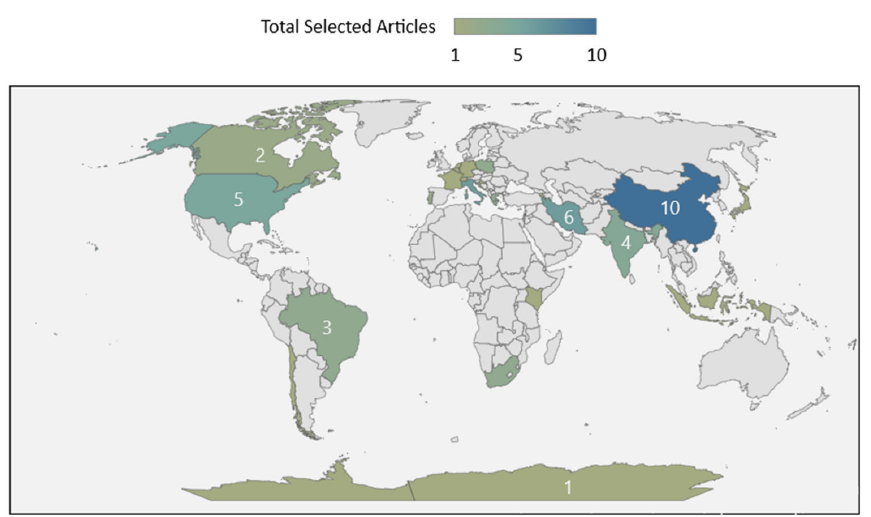
Figure 2. Geographical distribution of selected articles shown by country (white numerals show total articles per country).